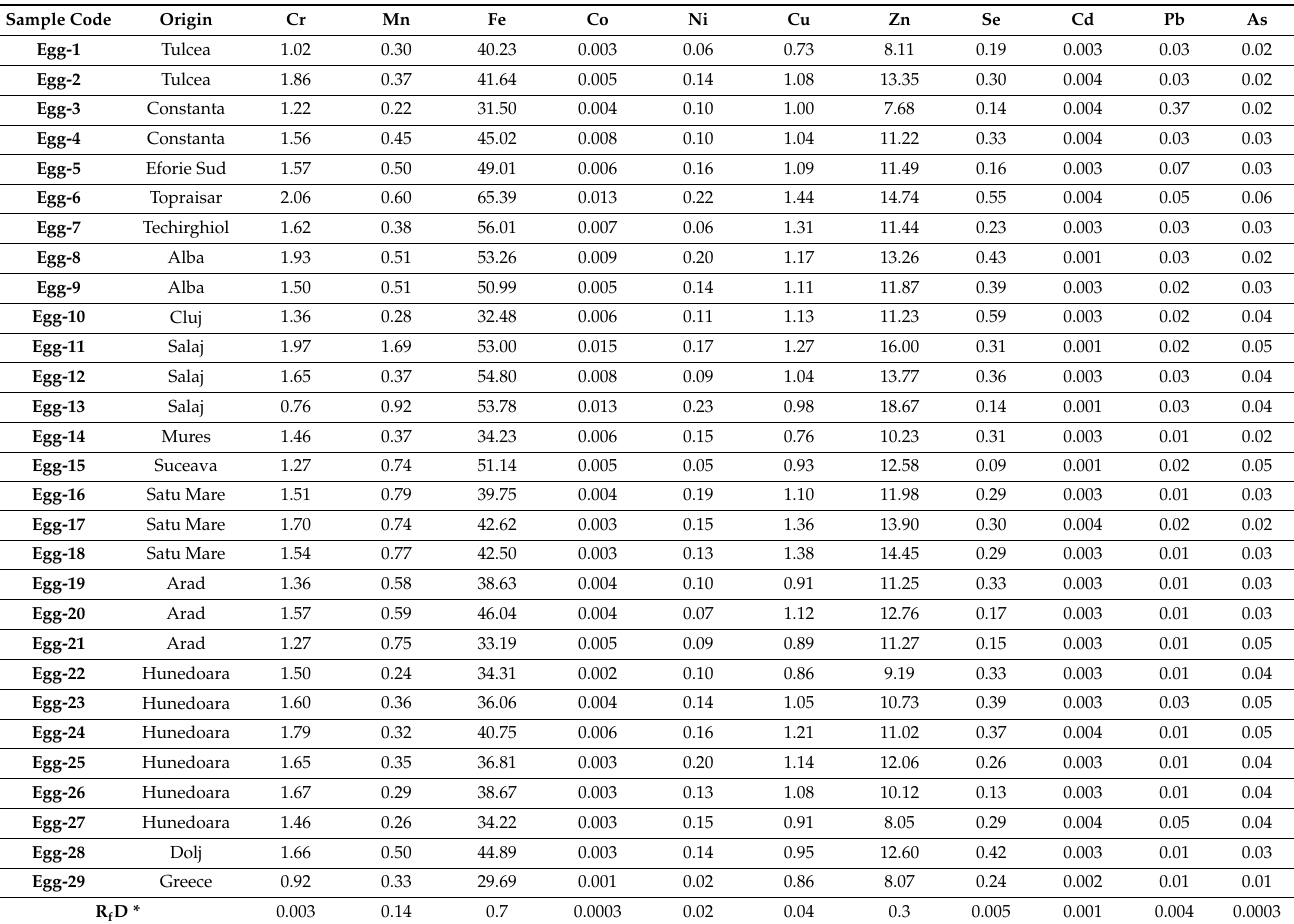
Table 3. The essential trace elements and toxic metals concentrations (mg/kg fresh weight) of whole egg